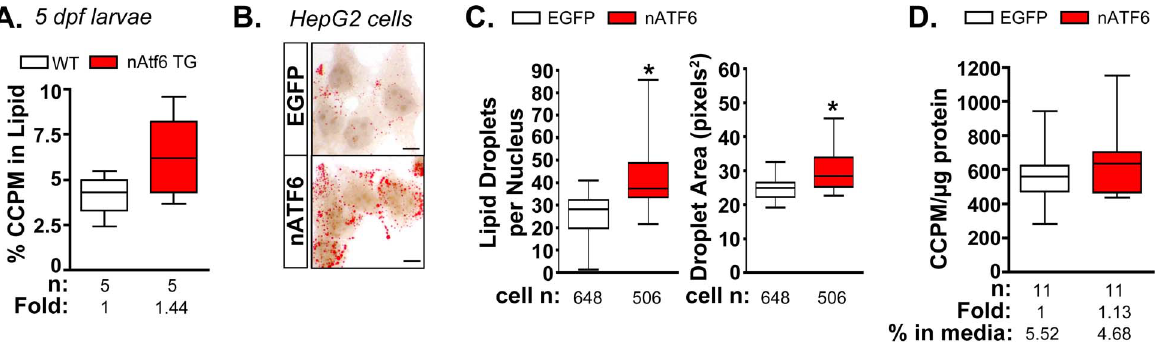
Figure 4. Denovo lipogenesis is enhanced invitro and invivo by nAtf6 overexpression. A: 14 C-acetate is preferentially incorporated into lipids in 5 dpf nAtf6 TG larvae compared to WT. The percent of 14 C in lipid fraction was divided by 14 C measured in the unextracted lysate from whole fish. The median fold change is noted; n= number of samples of pooled larvae. B: Oil red O staining of HepG2 cells transfected with GFP or nATF6. Bar =10 m m. C: Quantification of lipid droplet number and area (square pixels). Statistics: unpaired t-test. *, p , 0.05; n indicates the number of cells quantified over 20 fields from 2 independent experiments. D: Incorporation of 14 C-acetate into lipids by HepG2 cells transfected with GFP or nATF6 normalized to protein. The median fold change is noted; n= number of separate batches of cells analyzed in 2 independent